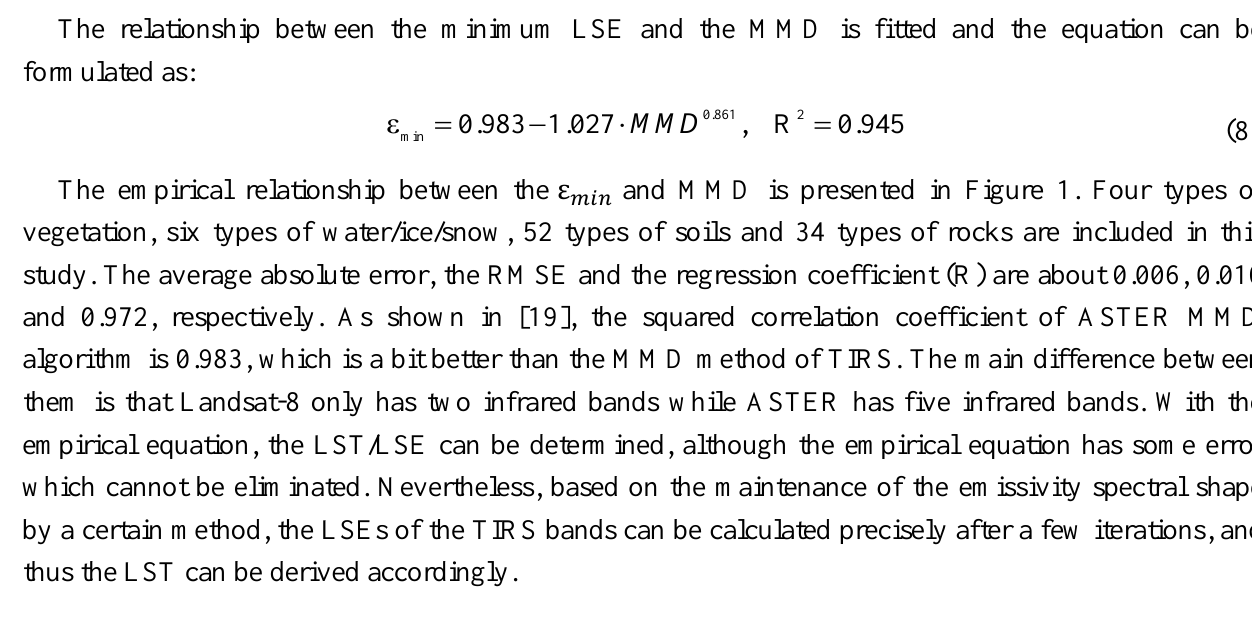
and MMD of Landsat-8 TIRS data. 𝑚𝑖𝑛